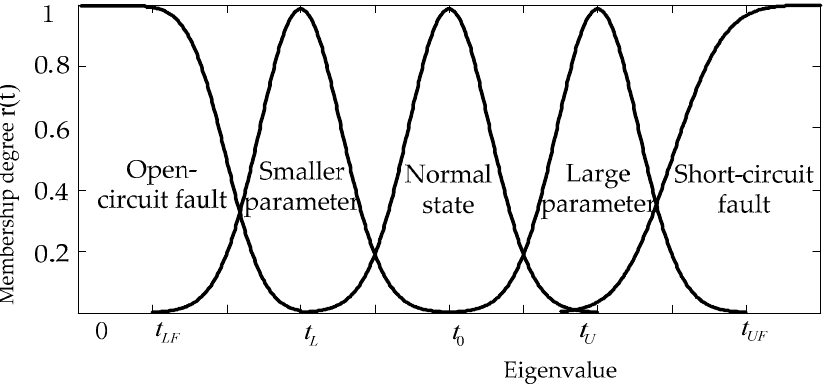
Figure 1. Membership degrees corresponding to eigenvalues. ( t ) , r ( t ) , r ( t ) , r ( t ) , and r ( t ) are membership degrees of test indicators subjected r 1 j 2 j 3 j 4 j 5 j